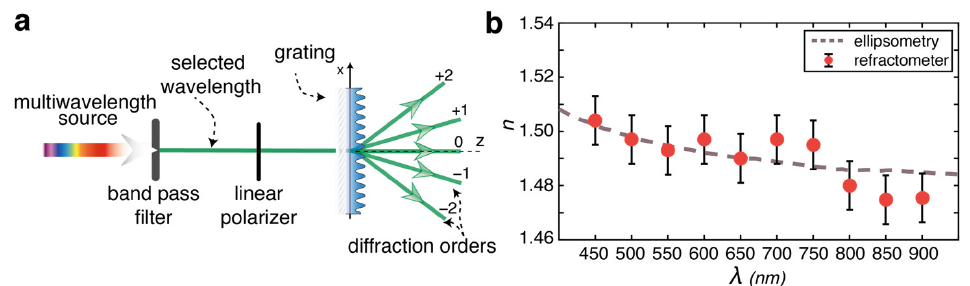
Figure 4. Measurement of the PMMA refractive index dispersion at discrete wavelengths using the diffractive refractometer. ( a ) Schematic of the optical setup. ( b ) Comparison of the measured refractive index n ( λ p ) and ellipsometry data from ref.